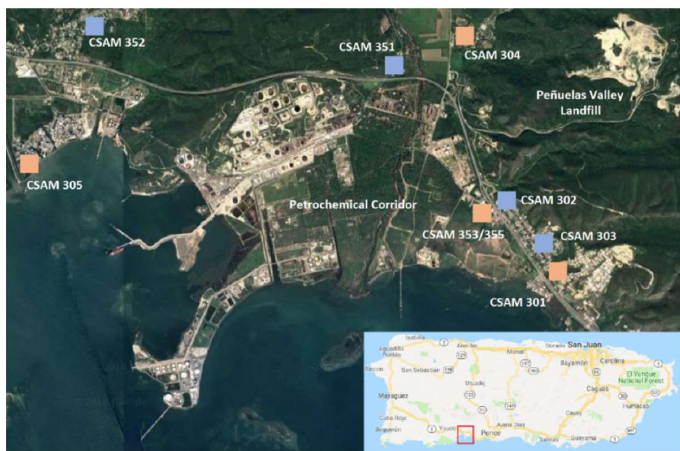
Figure 1. The deployment area in southern Puerto Rico is identified on the inset map with a red box. Approximate locations of CSAMs in the deployment area are identified with blue markers and locations with both a CSAM and weather station are identified with red markers. Image credit Google.